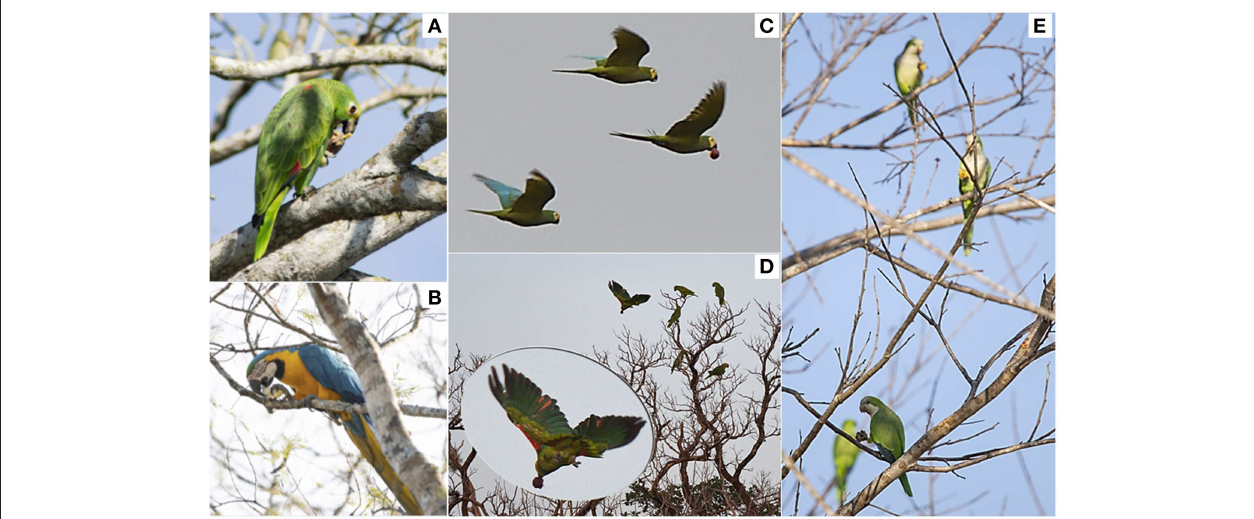
FIGURE 3 | Photographs illustrating examples of primary external dispersal of palm seeds by parrots: (A) Amazona ochrocephala and (B) Ara ararauna feeding on the pulp of Attalea princeps fruits moved from mother palms to perching trees; (C) Orthopsittaca manilatus flying with a Mauritia flexuosa fruit; (D) Amazona aestiva departing from a perching tree with a Mauritia flexuosa fruit (a two-phase dispersal); (E) three Myiopsitta monachus individuals feeding on the pulp of Acrocomia totai fruits moved from mother palms to a perching tree. Photographs taken by J. Salguero (A,B,E) and M. de la Riva (C,D) .